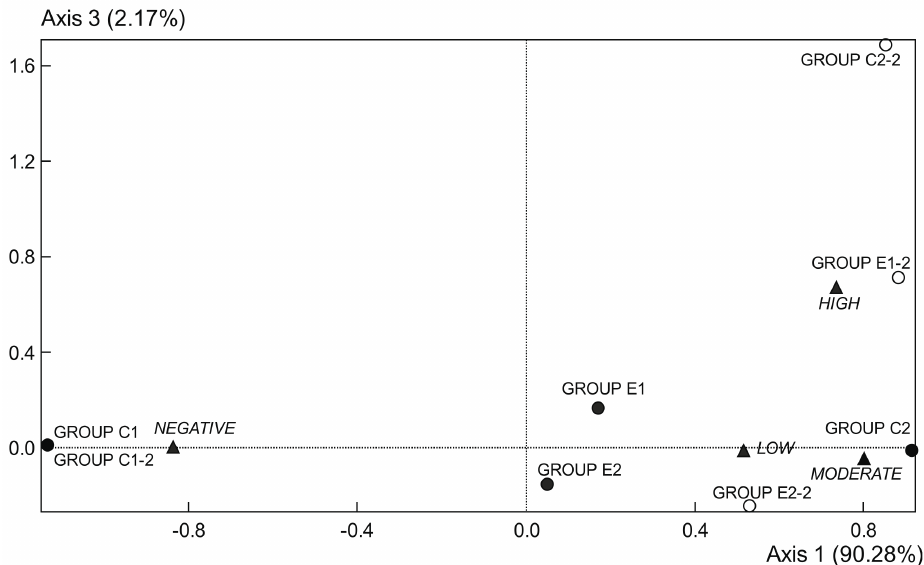
Figure 2. Correspondence analysis scores; plot of occult fecal blood data from 1st week ( • ) and 9th week ( ). Data points represent replicates of the experimental groups ( C1 , C2 , E1 , and E2 ), (cid:35) and intensities of staining ( (cid:78) ) (from absence to very intense). C1 wild strain fed a control diet, C2 Apc Min/+ fed a control diet, E1 Apc Min/+ fed a diet supplemented with microencapsulated Bf and Lg , E2 Apc Min/+ fed a diet supplemented with microencapsulated Bf , Lg, and